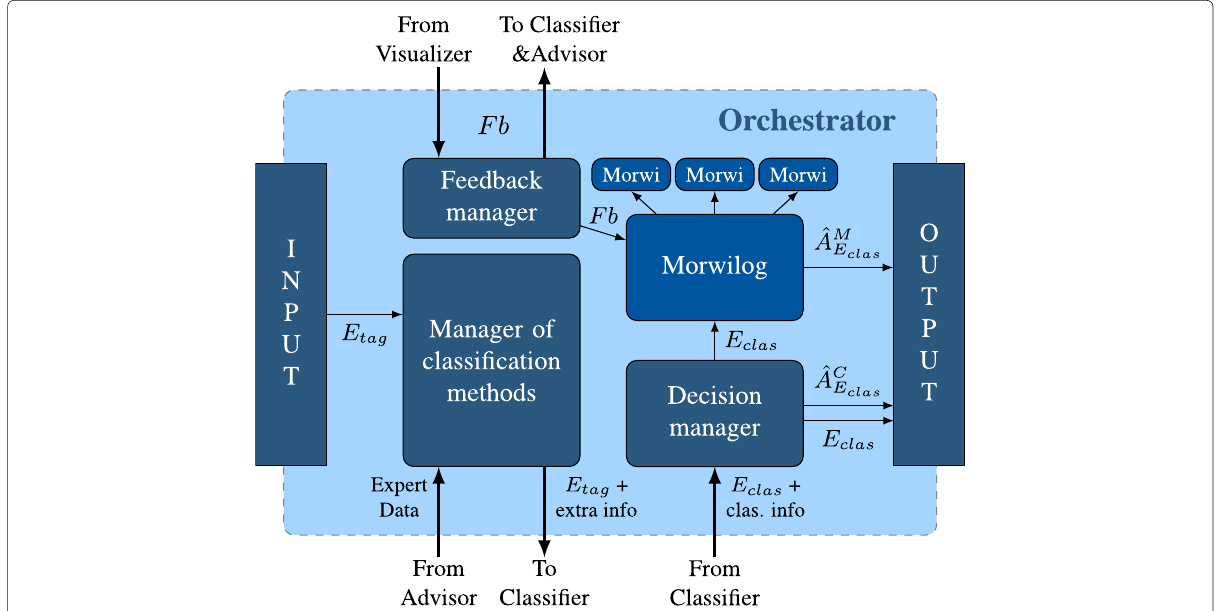
Fig. 10 Diagram of the structure inside the Orchestrator. Input is coming from the Matcher. Output goes towards the Logger, the Visualizer, and the